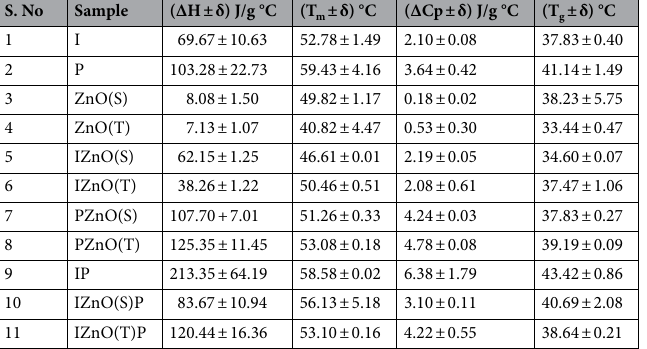
Table 3. DSC measurements of samples. ΔH, average change in enthalpy; Tm, average temperature corresponding to peak value in DSC thermograph curve having range 30–100 °C; ΔC p , average change in specific heat; T g , average temperature at half Cp extrapolated; δ, variation of two independent runs. Scan rate 20 °C/min.